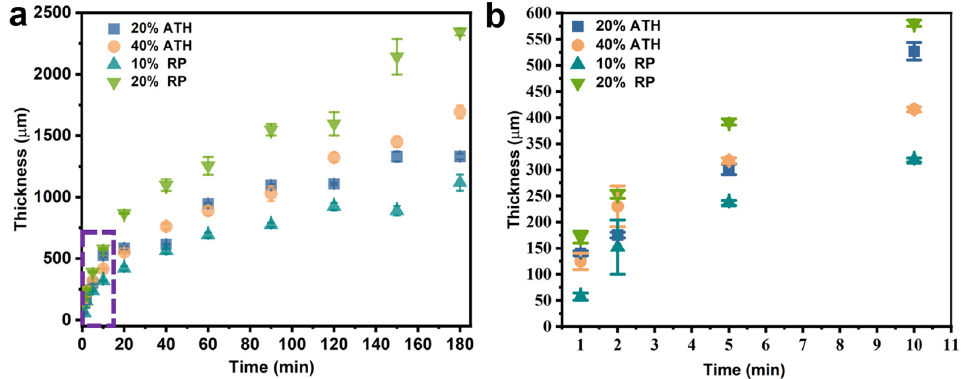
Figure 2. ( a ) The relationship between film thickness and preparation time of the emulsion with different flame retardant concentrations at 2 V; ( b ) the relationship between film thickness and preparation time in the first 10 min.